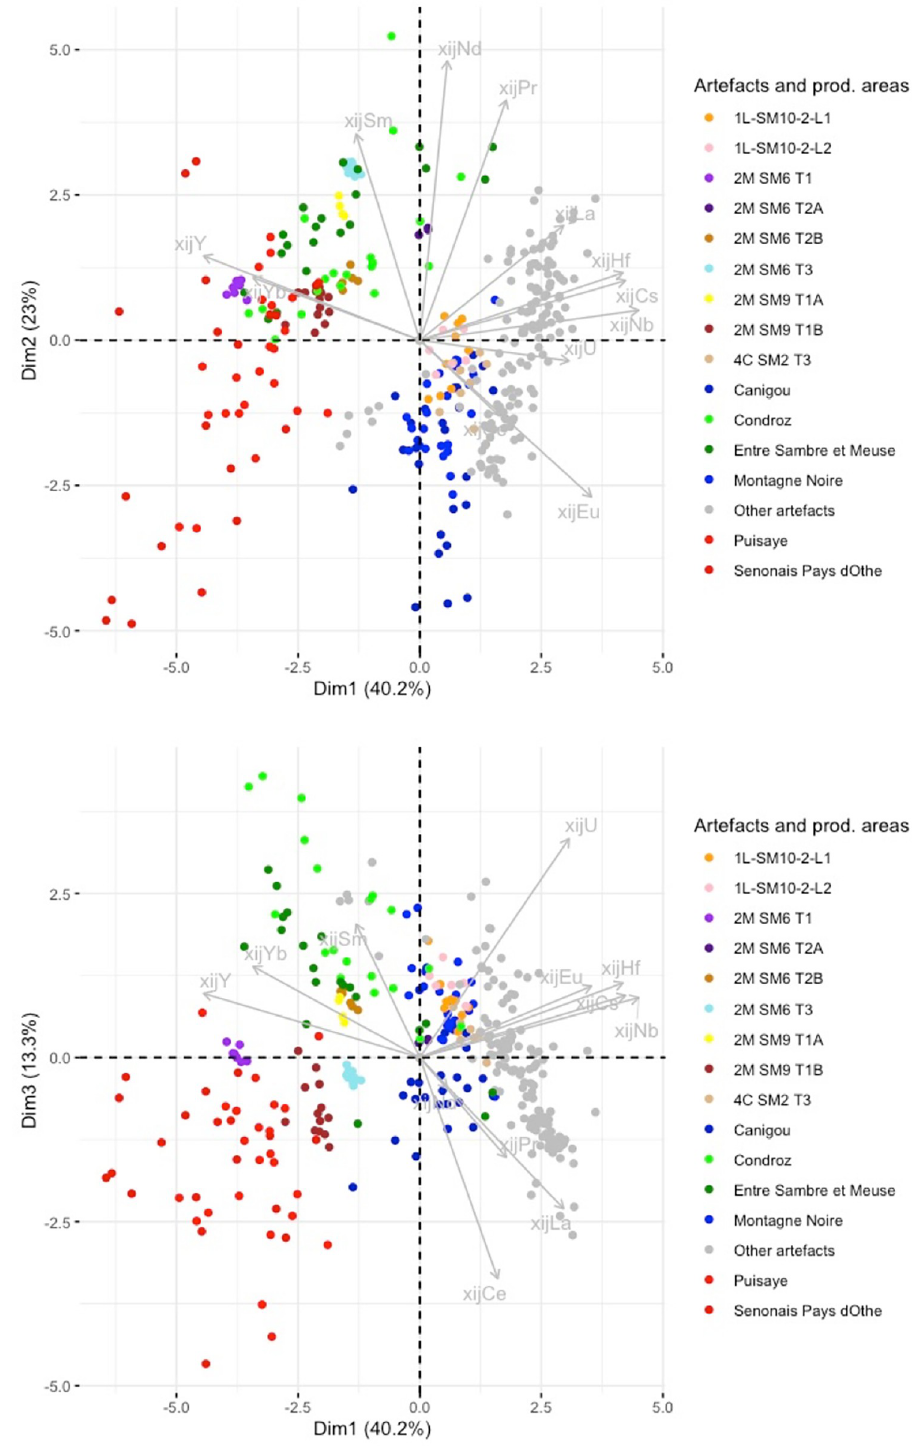
Fig 17. PCA on xij of production area slag. Artefacts consistent with a production area are highlighted. % of total variance.